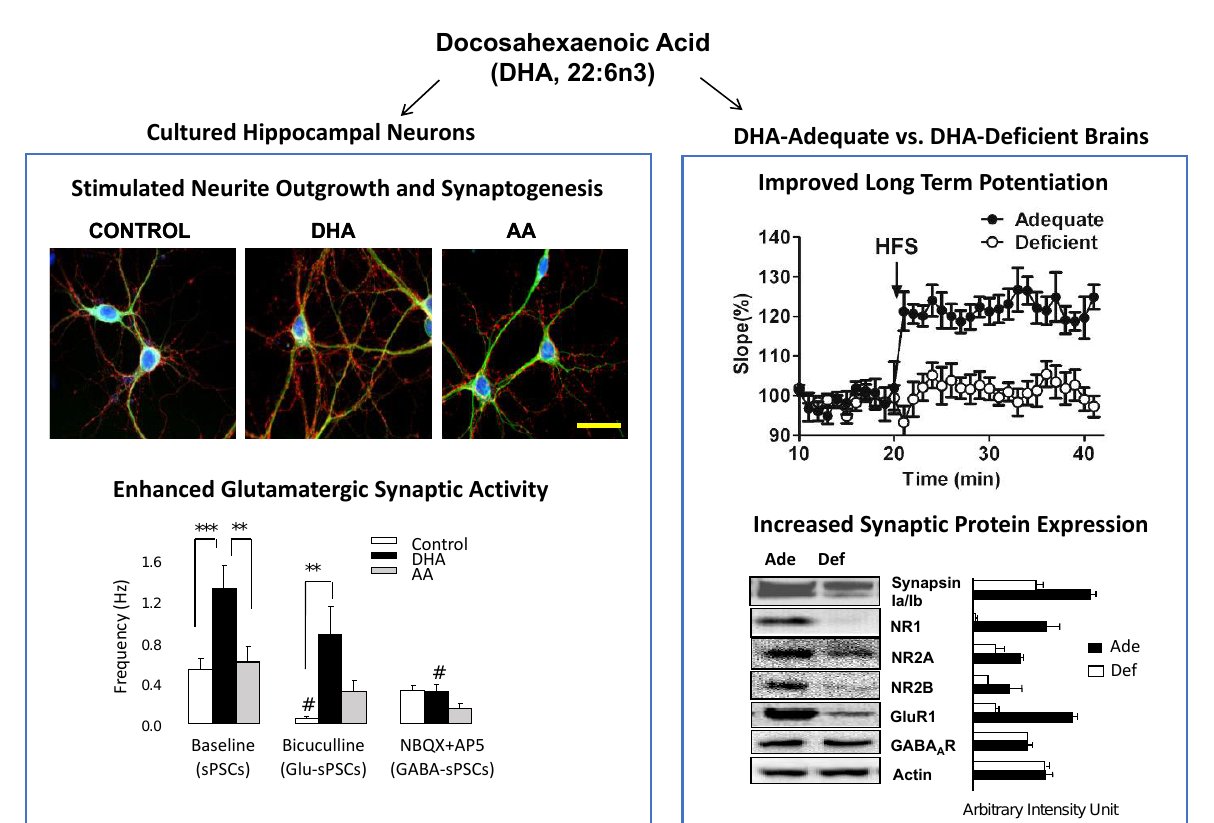
Figure 1. Neurodevelopmental effects of DHA. DHA among fatty acids uniquely promotes neurite growth, synaptogenesis, and glutamatergic synaptic activity in cultured hippocampal neurons. DHA-adequate mouse brains show improved LTP and increased synaptic protein expression compared to DHA-deficient brains. Markers used for the staining of hippocampal neurons include DAPI (for nuclei, blue), synapsin1 (a presynaptic marker protein, red), and MAP2 (a neuronal marker protein, green). AA, arachidonic acid. Adapted from reference [4].